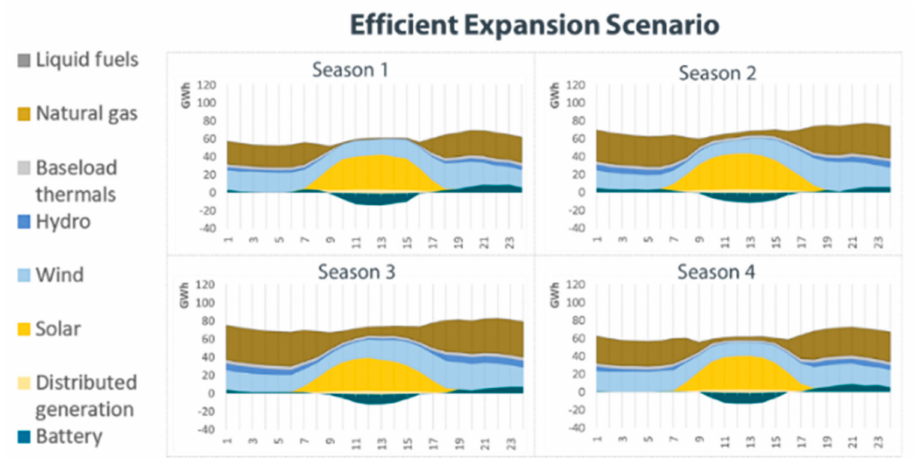
Figure 18. Generation profile per season in the efficient regulation scenario.